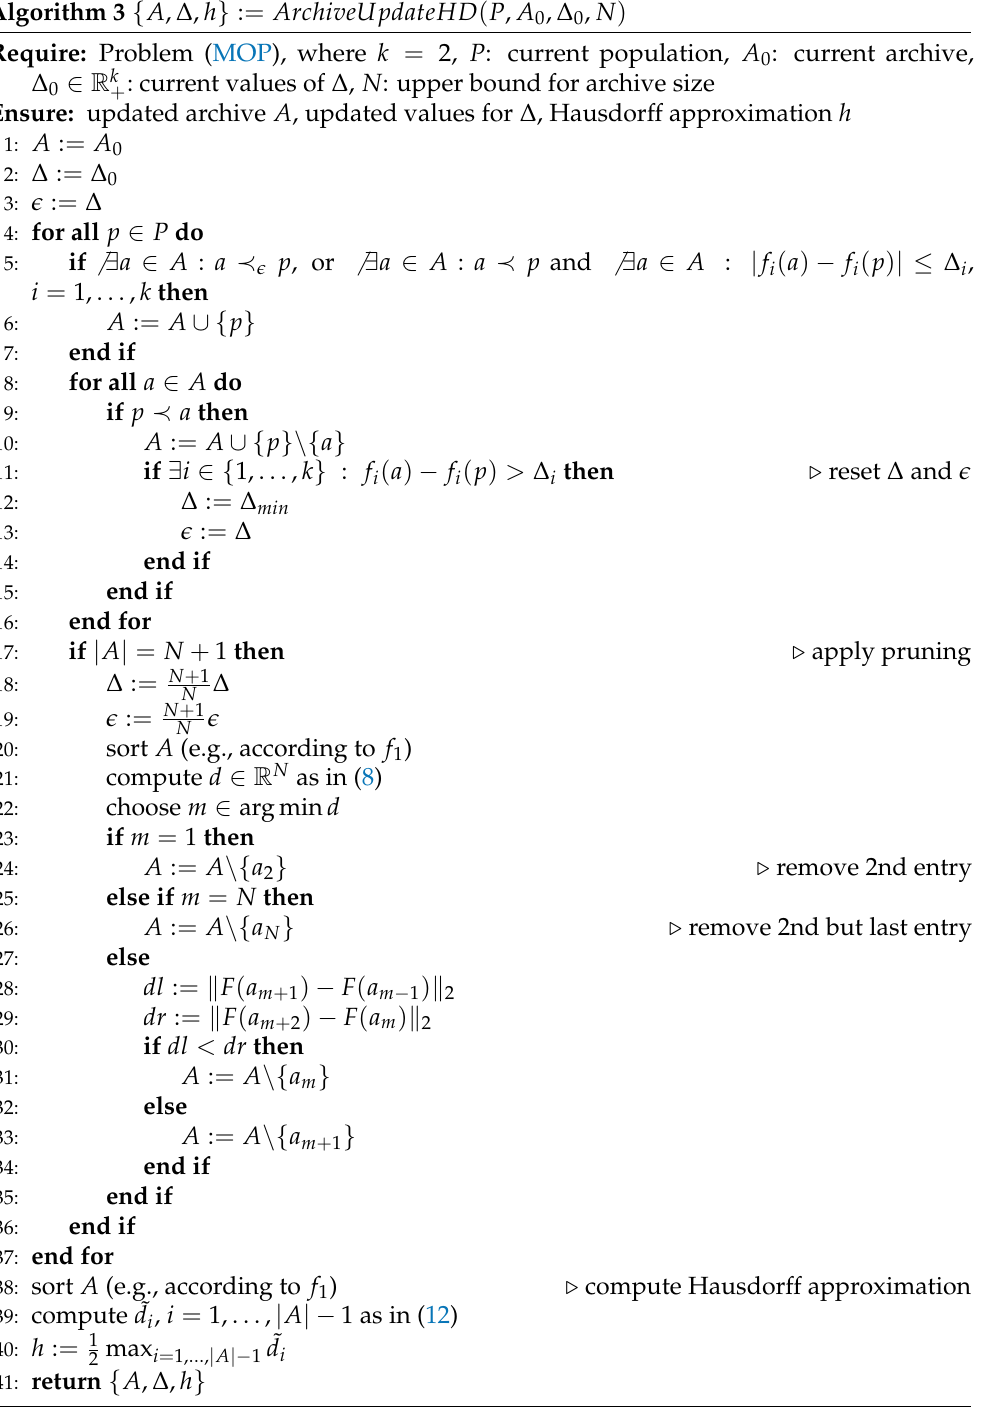
Algorithm 3 { A , ∆ , h } : = ArchiveUpdateHD ( P , A 0 , ∆ 0 , N